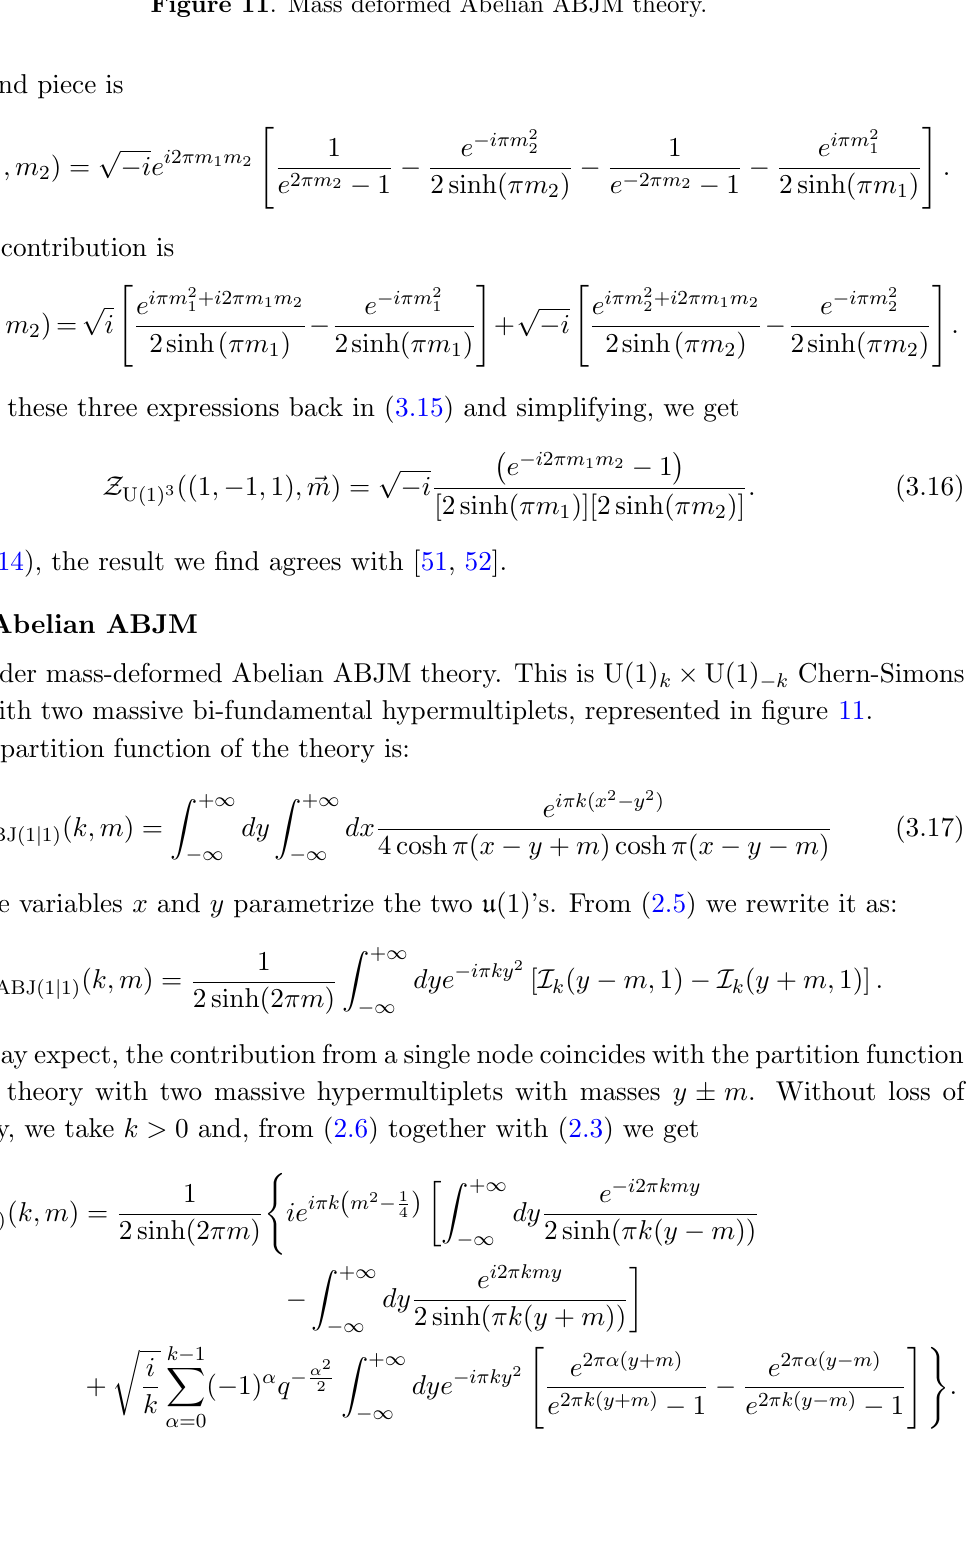
Figure 11 . Mass deformed Abelian ABJM